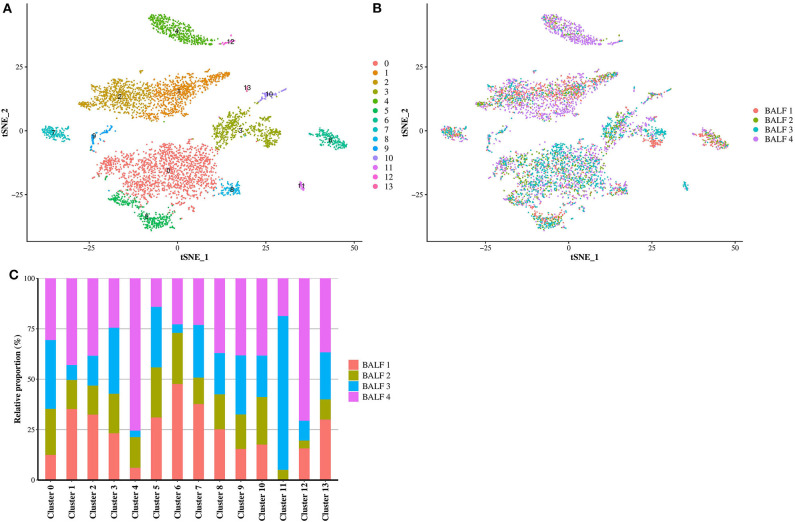
Compiled t-SNE plot of the cell clusters. (A) t-SNE plot of all cells (n = 5,710) representing the cell clusters analyzed by scRNA-seq. Each color corresponds to one cluster assigned via the graph-based clustering method with a resolution of 0.3. (B) Batch alignment across bronchoalveolar lavage fluid (BALF) specimens, each color representing the cells coming from one sample. (C) Bar plot showing the relative proportion of the cell from each BALF sample into each cluster. BALF 1, female Yorkshire terrier of 11-year-old; BALF 2, female French bulldog of 4-year-old; BALF 3, female West Highland white terrier of 9-year-old; BALF 4, female Australian shepherd of 6-year-old.